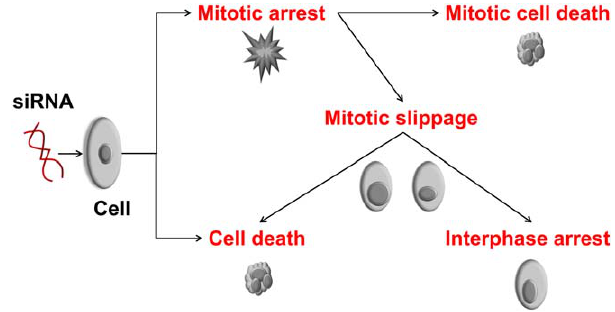
Figure 1. Consequences of a gene knockdown on the cell cycle and cell fate. These effects can be observed (directly or indirectly) by imaging cells with silenced genes following a mitotic time-lapse screening assay. Cells may directly be affected from a loss-of-function of a gene and die (cell death), they may enter mitosis and die before completion of mitosis (cell death in mitotic arrest) or may undergo mitotic slippage followed by interphase arrest or cell death [23].